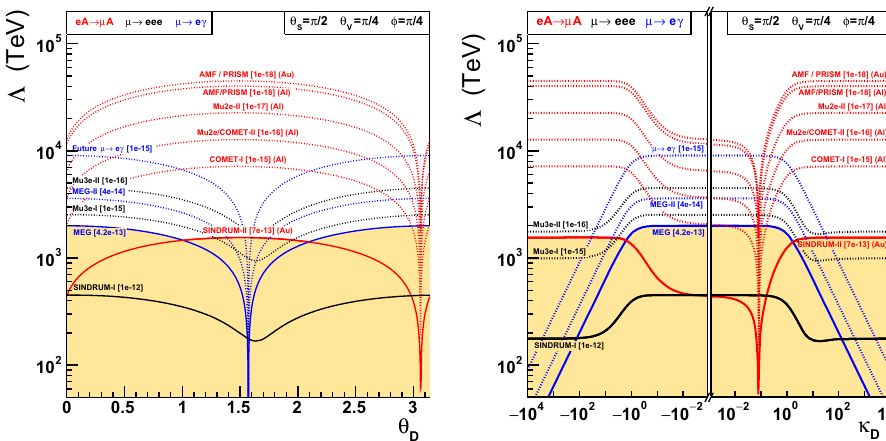
Fig. 1 Reach as a function of (left) the angle θ D , which parametrizes the relative magnitude of dipole and four-fermion coefficients, and (right) the variable κ = cotan (θ − π/ 2 ) . The D D scale (cid:4) is defined in Eq. (2.1)